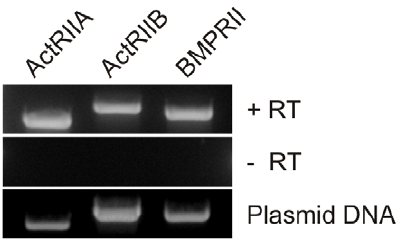
Figure 3C). Expression of individual BMP receptor shRNAs